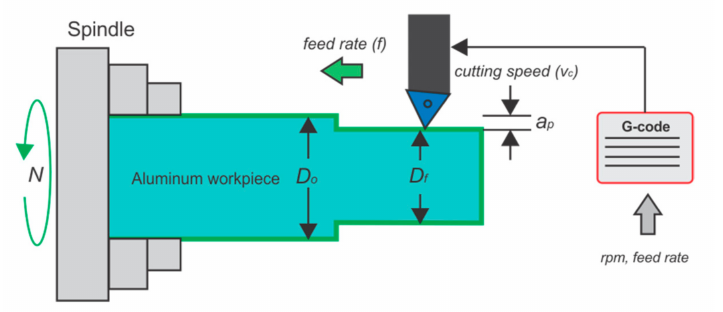
Figure 3. Machining process and cutting parameters.